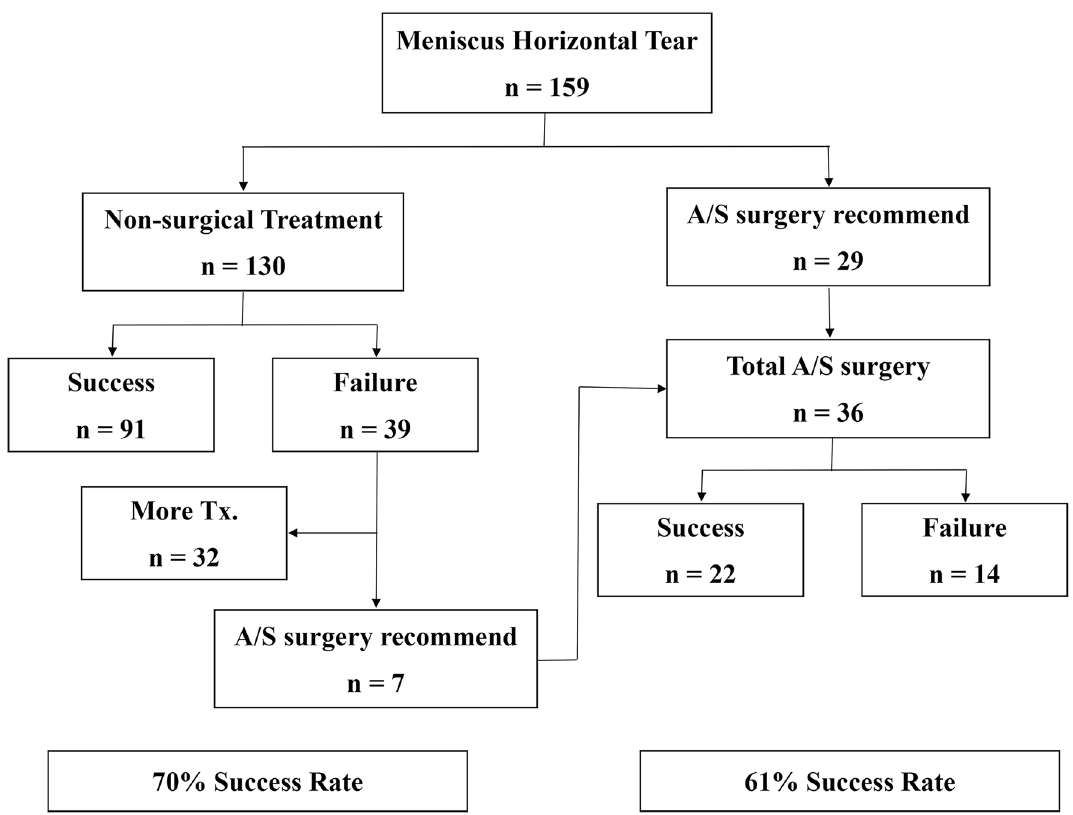
Figure 1. Flowchart of the study. n number of patients, A/S